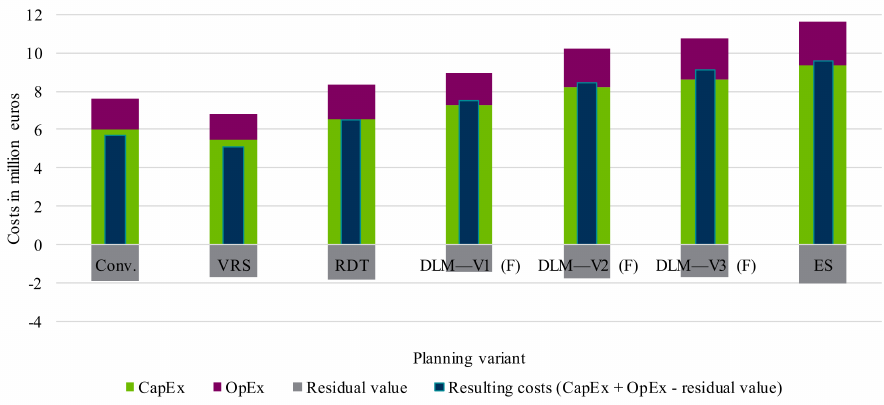
Figure 18. Resulting costs (CapEx + OpEx—residual values) consolidated across all conventional and innovative planning variants for 18 low-voltage